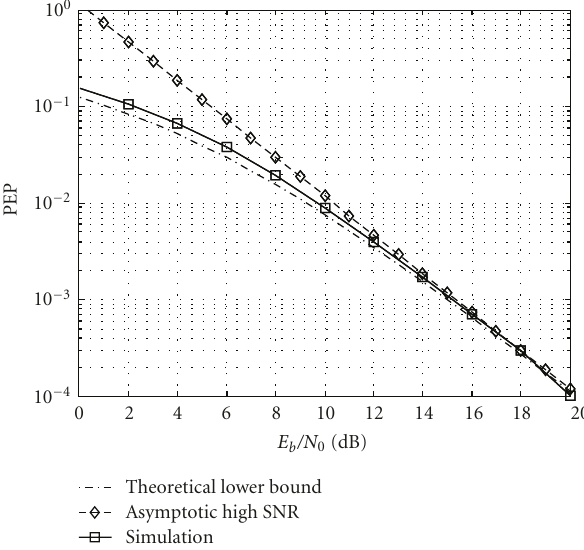
Figure 9: Theoretical and simulated error probability for RA- Precoded scheme with M = 1.